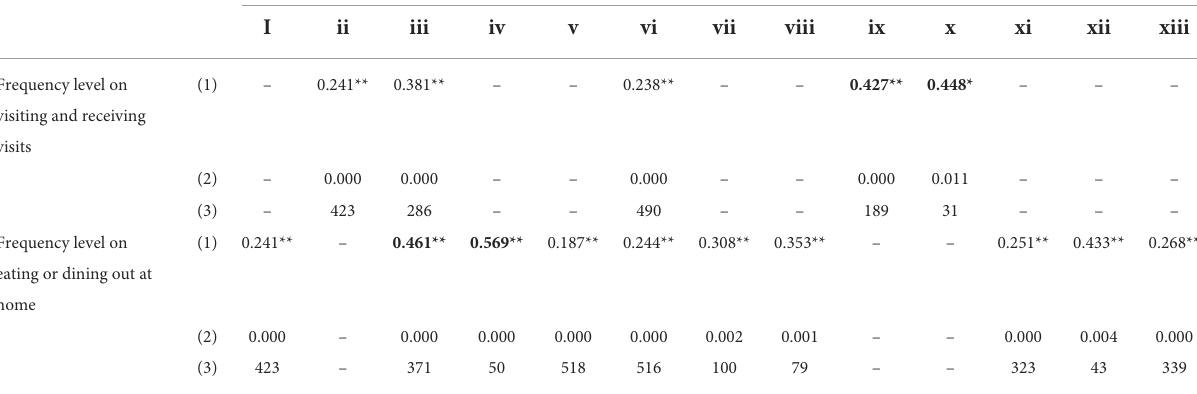
TABLE 4 Correlation on activity performance.